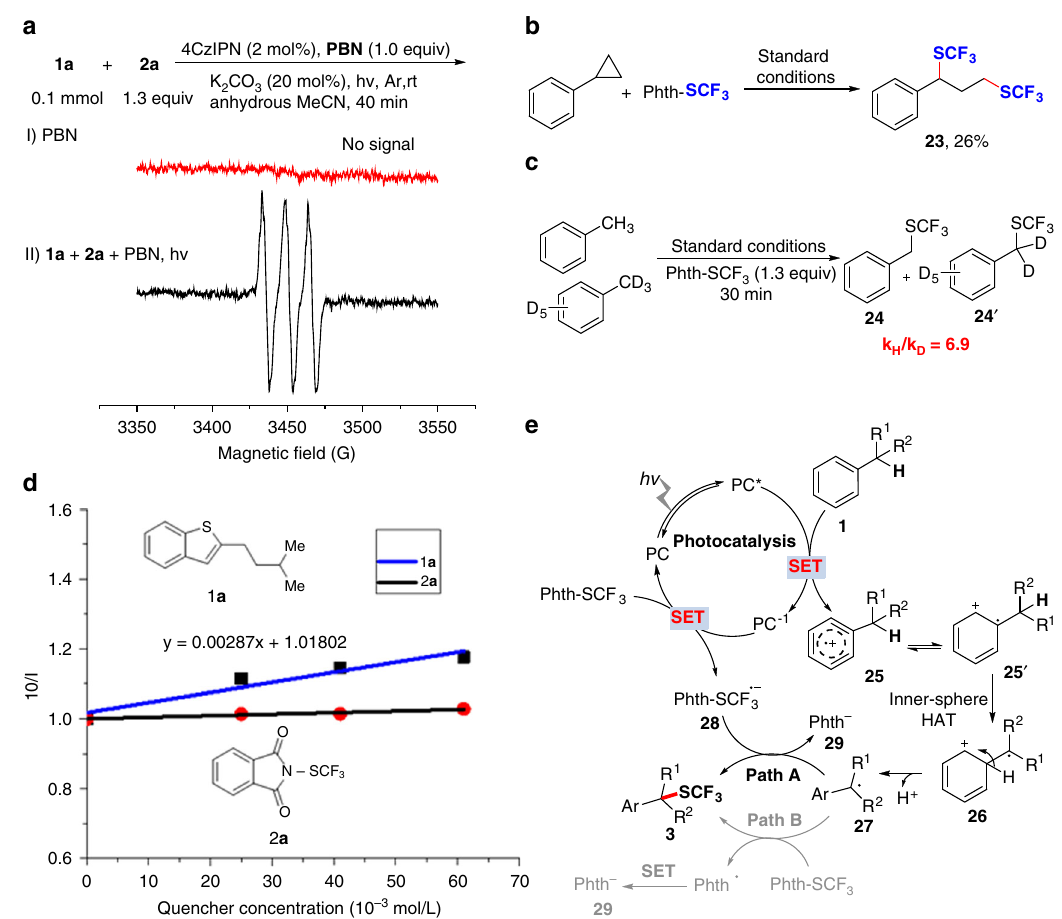
Fig. 4 Mechanistic studies. a The EPR experiment. b The radical clock experiment. c KIE experiments. d The luminescence quenching experiment. e The proposed